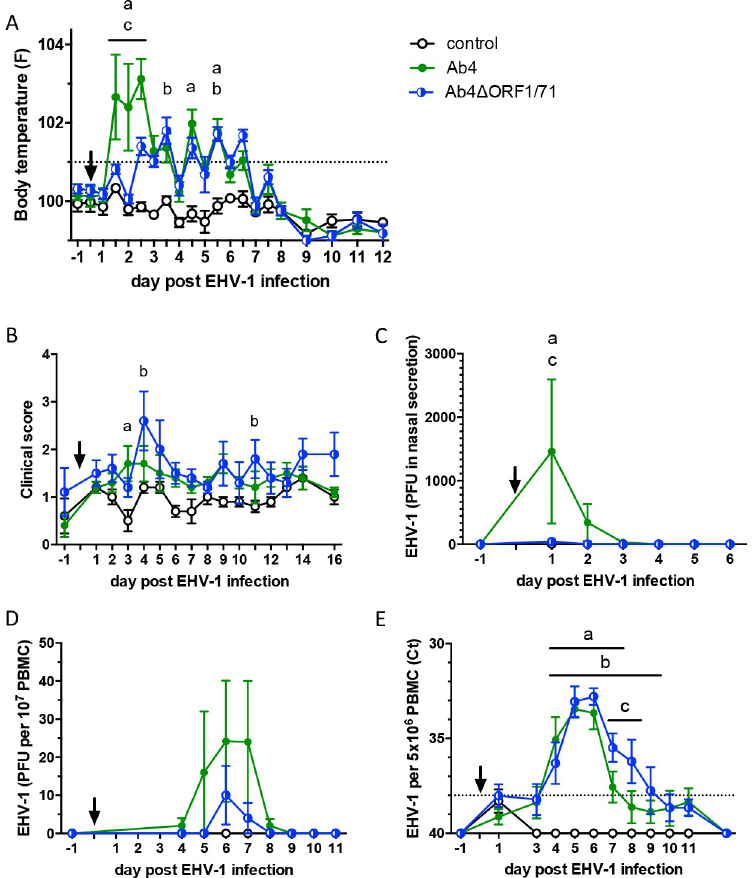
Fig 1. Body temperatures, clinical scores, nasal viral shedding and viremia after experimental EHV-1 infection of na ï ve horses. The horses were infected with EHV-1 strain Ab4 (n = 5) or deletion mutant strain Ab4 Δ ORF1/71 (n = 5). The arrow points to the time of infection (d0). A non-infected control group (n = 5) was included. (A) Body temperatures. The dotted line shows the cut-off value for fever of 38.5˚C; (B) total clinical score determined by the summation of several clinical variables evaluated on a numerical scale; (C) EHV-1 in nasal secretions measured by virus isolation; (D) viremia measured by virus isolation from PBMC; (E) viremia determined by real-time PCR. The dotted horizontal line shows the positive PCR Ct-value cut-off value. All graphs show means and standard errors by group. Significant differences between groups are marked: a = Ab4 vs. controls, b = Ab4 Δ ORF1/71 vs. controls, and c = Ab4 vs. Ab4 Δ